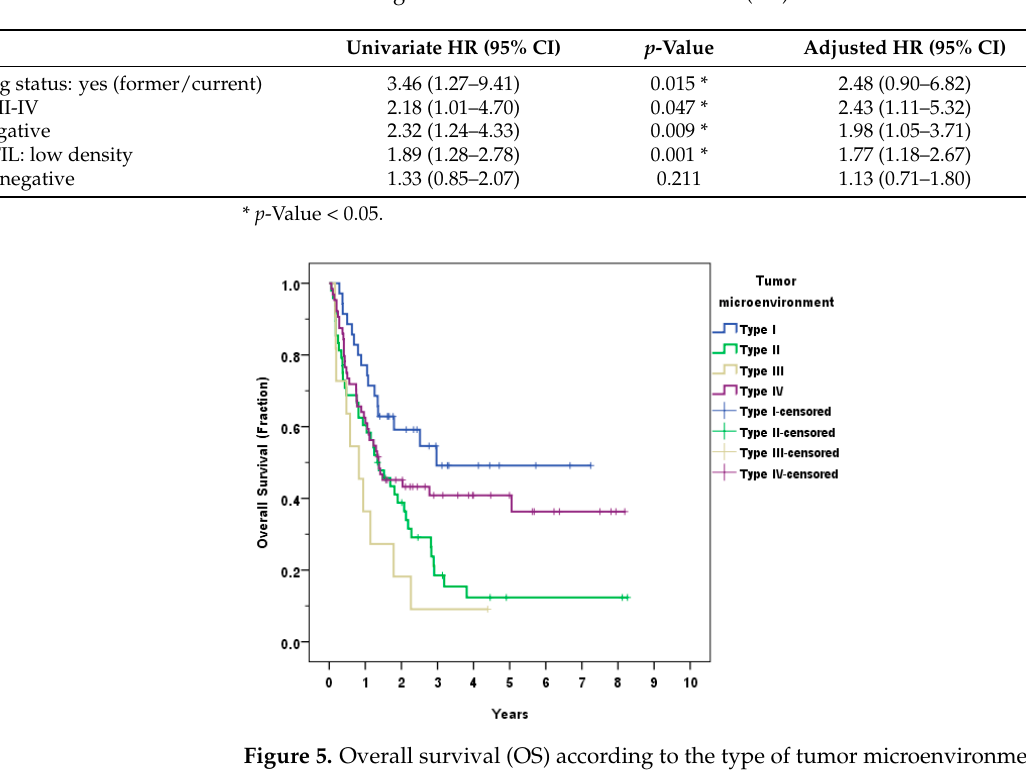
Table 4. Cox regression model for overall survival (OS).